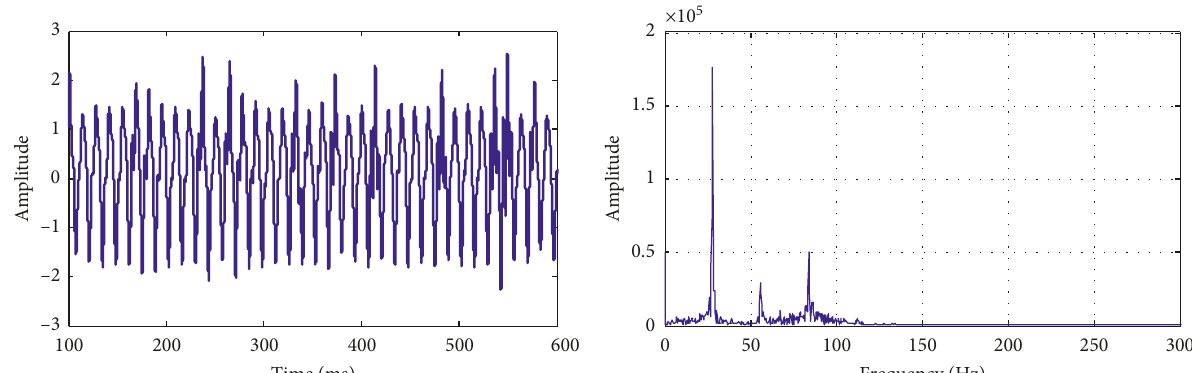
Figure 12: Vertical vibration amplitude signals and its frequency diagram on the disk.